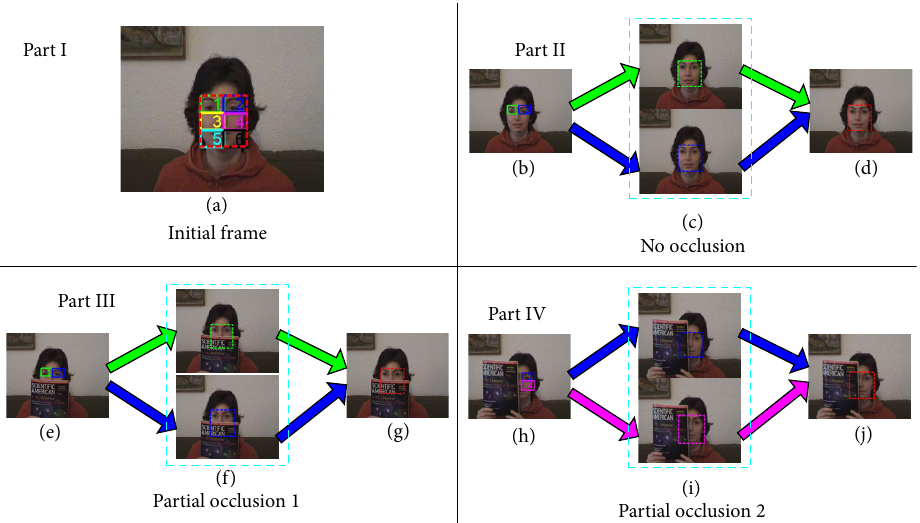
Figure 4: Illustration of tracking process. Part (I): segmentation of object in initial frame (first frame). Object is divided into six blocks. Part (II): tracking object without occlusion. Green block and blue block are selected as LFBs in image (b). Green and blue dotted line rectangles in image (c) are the tracking results of LFBs, and the red dotted line rectangle in image (d) represents the location of object estimated by the tracking results of LFBs. Part (III): tracking object with occlusion yet valid LFBs. Essentially, this process is similar to part (II). Occlusion does not affect the tracking. Part (IV): tracking object with occlusion with invalid LFB. In this part, green LFB is occluded and therefore invalid. We replace it with another new valid LFB, namely, the pink LFB, as shown in image (h). The object is then located in image (j) by tracking results of blue LFB and pink LFB in image (i).